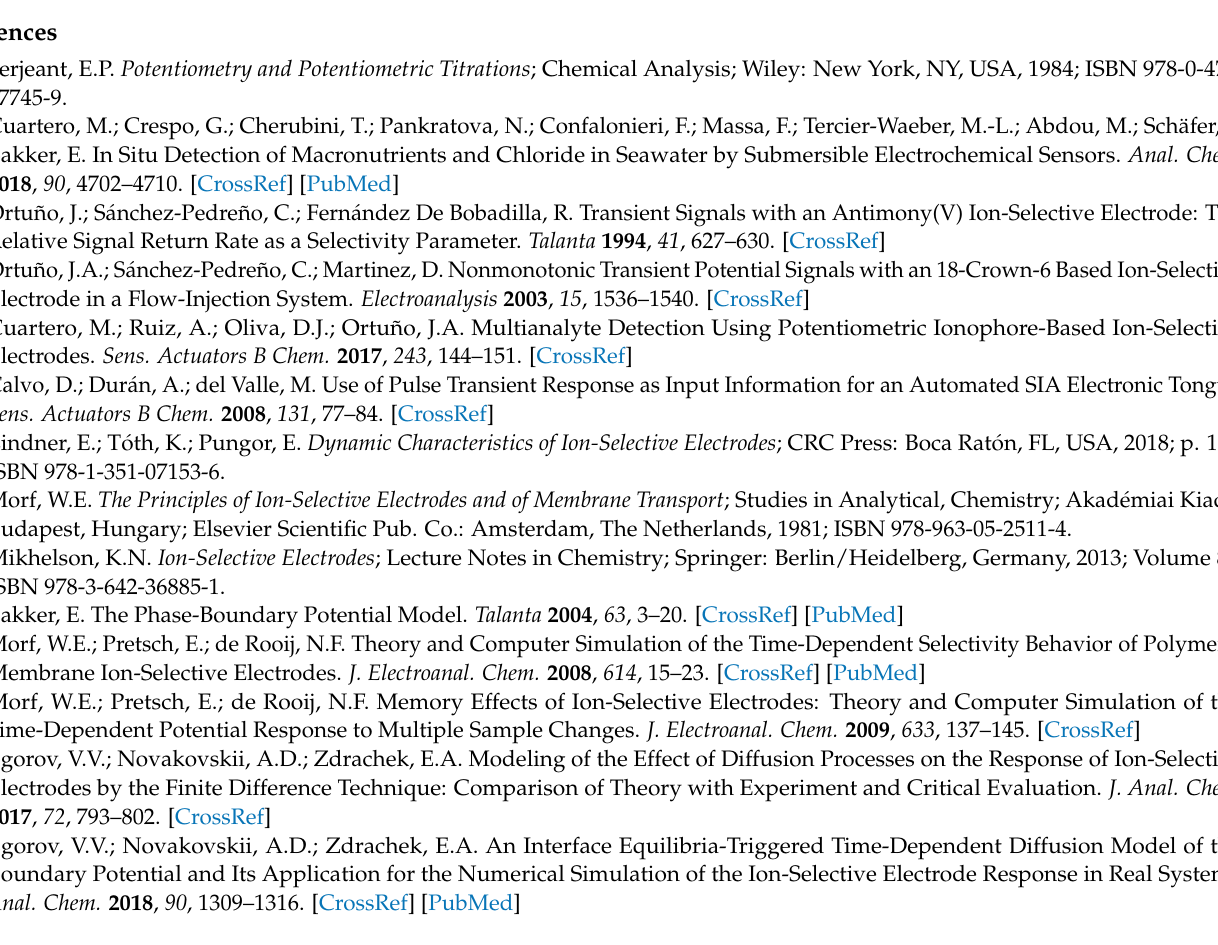
cations and mixtures (blue) and their corresponding reconstructed signals superimposed (red). Figure S2: Three-dimensional plots PC1 and PC2 scores versus log C (left) and plots of the concentra- tion values predicted versus the actual values (right) for H + , Li + , Ca 2+ , Mg 2+ , AcCh + , and Pr +